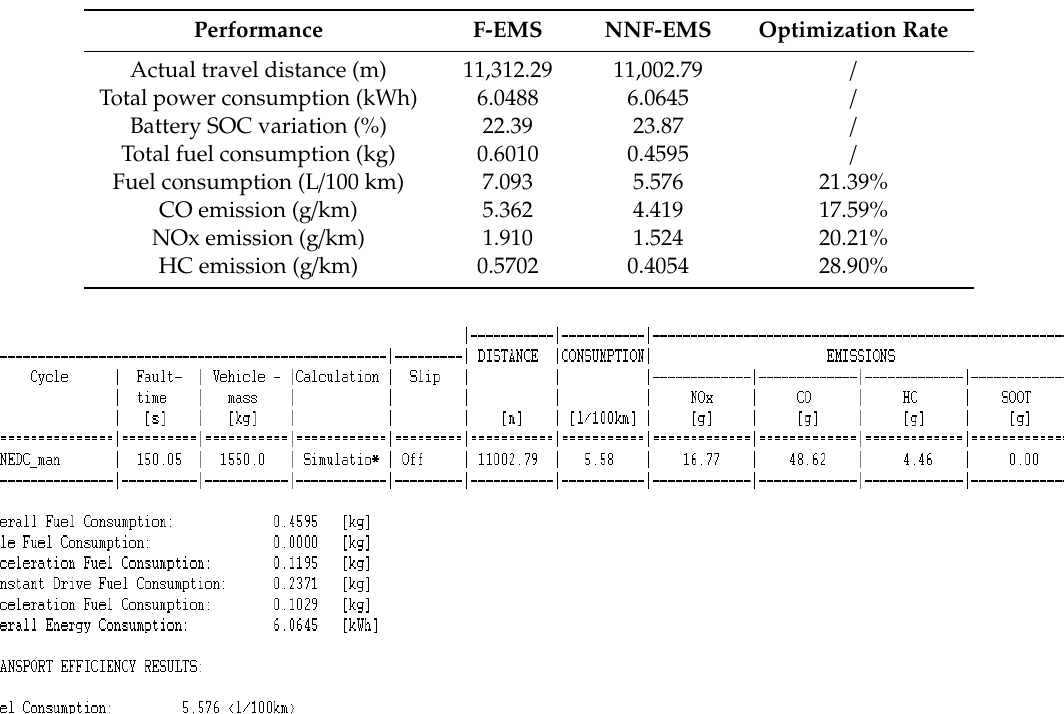
Table 3. Comparison of fuel economy and emission performance under NEDC cycles.